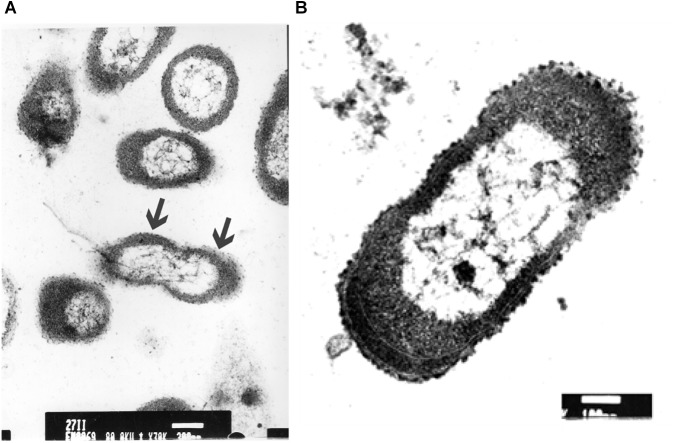
Electron microscopic images of P. aeruginosa swarmer cells removed from the swarm edge and observed at the population (A) and at the single-cell level (B). Bars: A = 300 μm; B = 100 μm. In A, the arrows show the waved outer membrane with some emanating blebs.